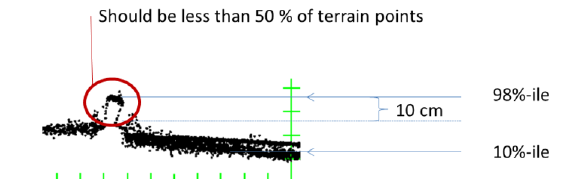
Figure 2. Potential rail track points are detected by histogram analyses of terrain